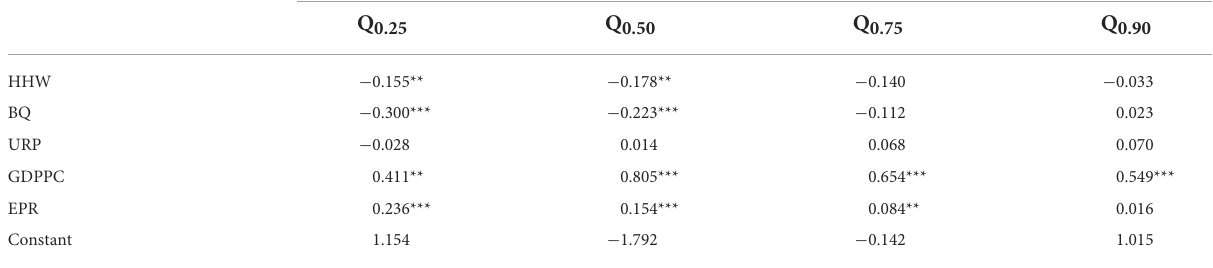
TABLE 8 Robustness test—quantile regression –